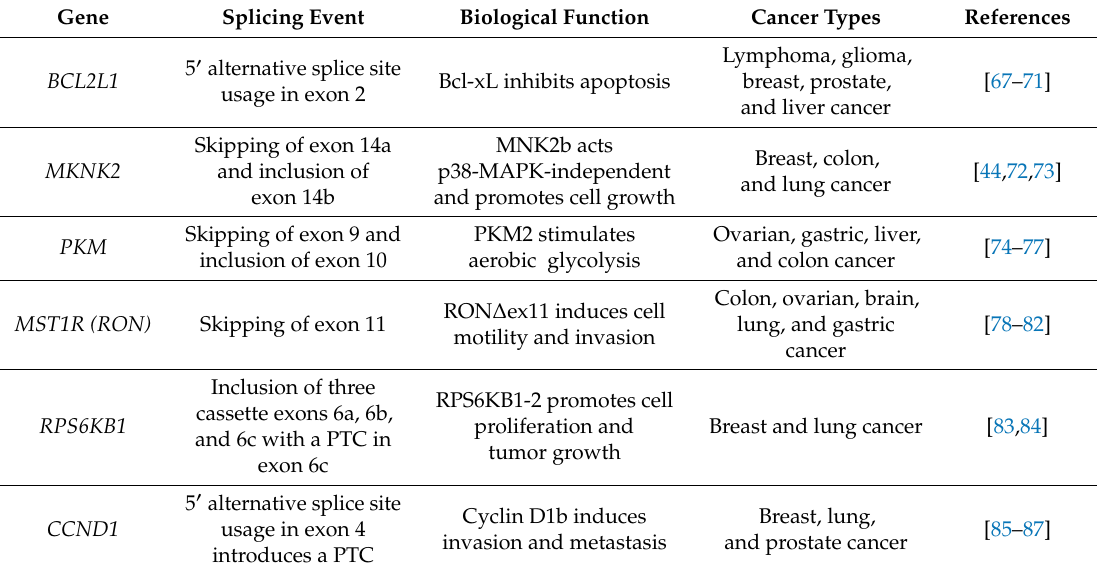
Table 1. Tumor-associated AS variants and the respective cancer-promoting